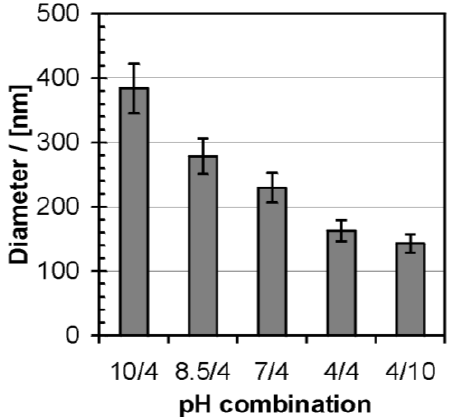
Figure 10. (From [18] with kind permission of Research Trends) Influence of pH combination [ i.e. , pH(PEI)/pH(PAC)] on the diameter D (n /n = 1.5, c = 0.005 − + PEL